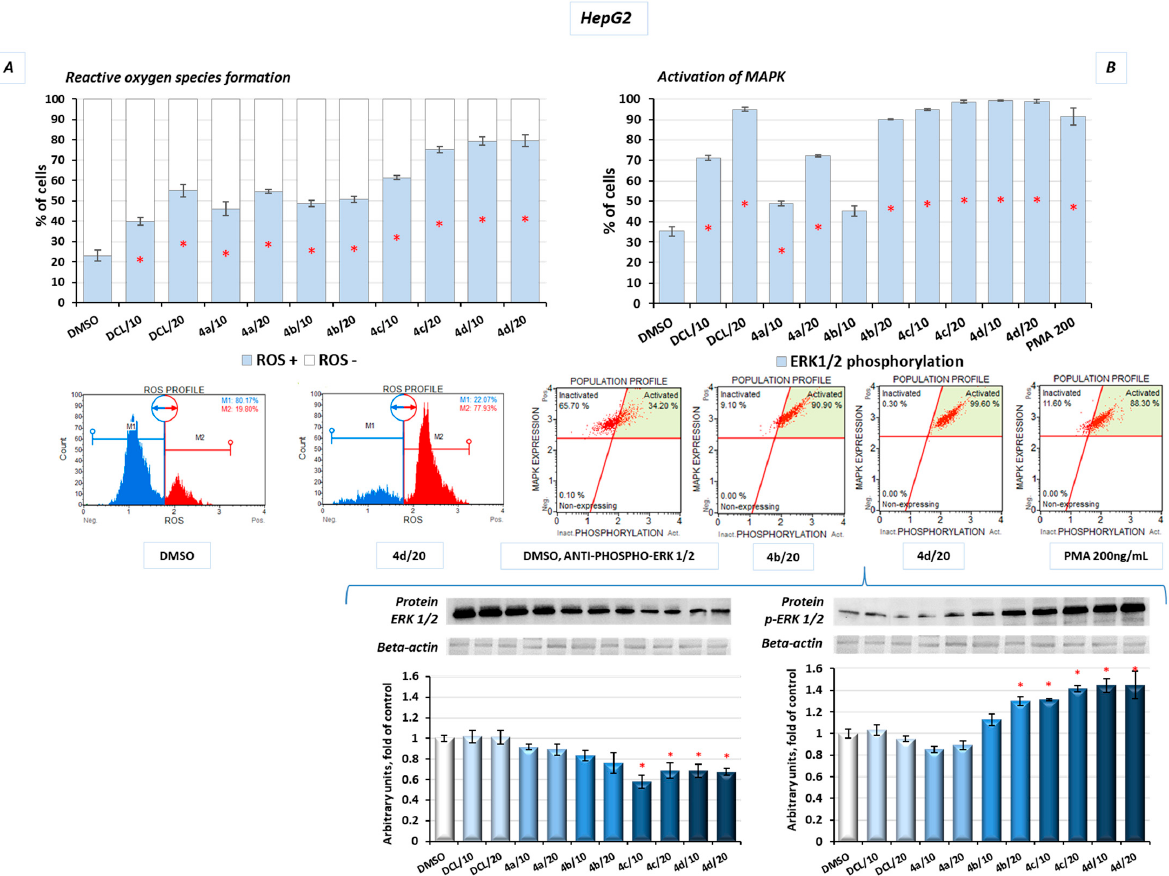
Figure 10. The effect of the DCL and DCL–OAO derivative conjugates ( 4a – 4d in 10 and 20 µ M concentrations) on the generation of reactive oxygen species (ROS (+)) ( A ) and induction of ERK phosphorylation ( B ) in the HepG2 cells (after 24